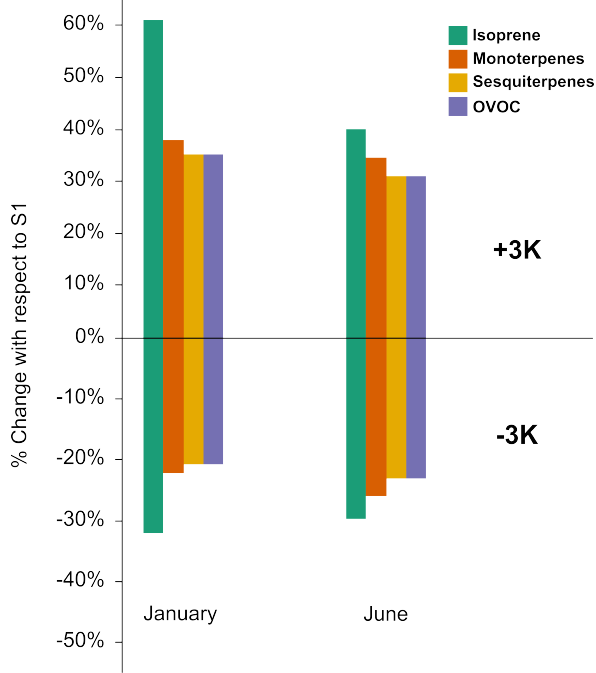
Fig. 8. Sensitivity of emissions to air temperature for S1 inventory in January and June 2006 (original countries). The sensitivities in S2 and S3 are very similar with differences in the ± 1% range. in southern Spain it is about 720µmolm − 2 s − 1 (factor of 1.18 higher). In January, average PAR levels are 50µmolm − 2 s −